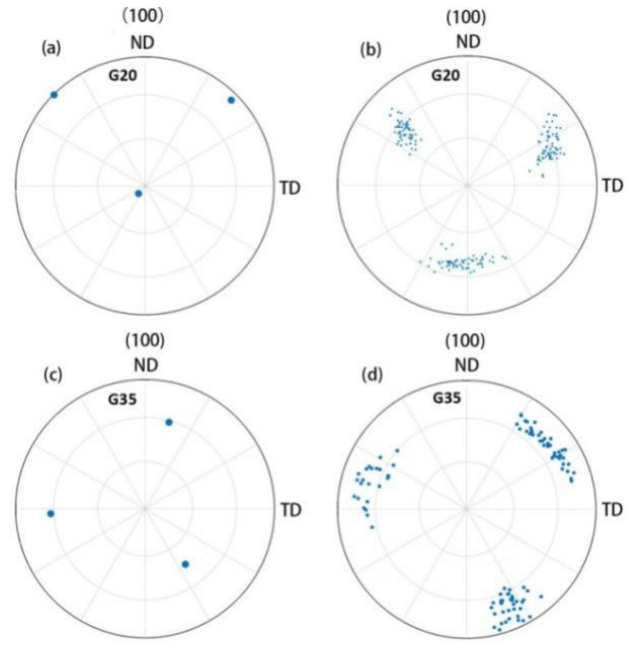
Figure 17. Pole figure before and after deformation: ( a , b ) G20; ( c , d ) G35. The pole figures before and after the thread rolling deformation are shown in Figure